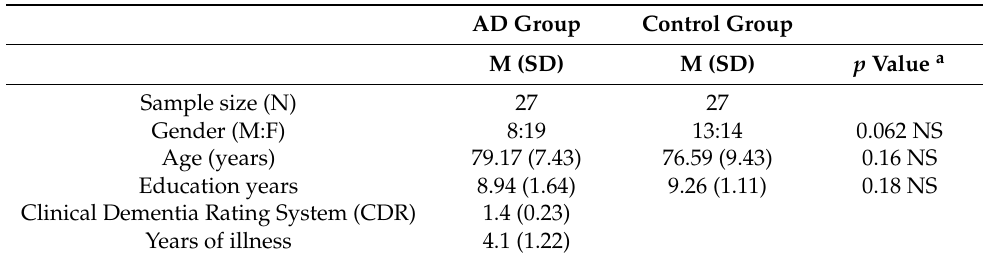
Table 1. Means (M) and standard deviations (SD) of several demographic characteristics of the Alzheimer’s disease (AD) and control